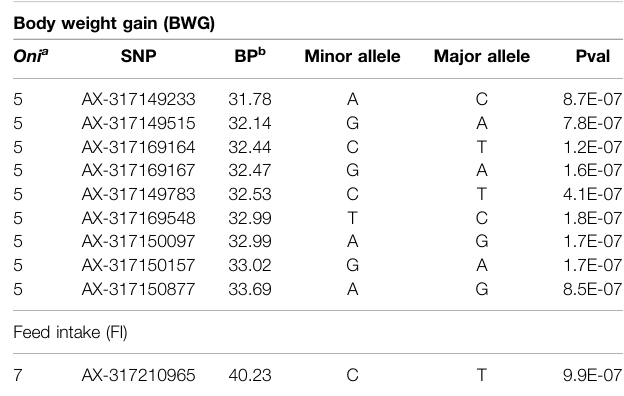
TABLE 4 | Information on the genomic location, allelic variants and summary statistics for the genome-wide signi fi cant markers associated with feed- ef fi ciency related traits in a Nile tilapia breeding